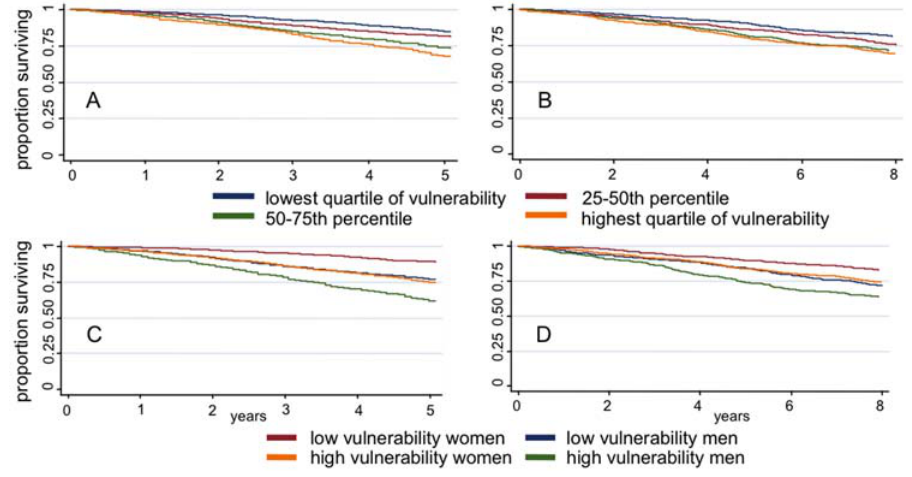
Figure 4. Survival by level of social vulnerability. Panels A (Canadian Study of Health and Aging) and B (National Population Health Survey) show decreasing survival by increasing quartile of social vulnerability. Panels C (CHSA) and D (NPHS) show that although women had better survival than men, survival for women with high social vulnerability was equivalent to that of men with low vulnerability.